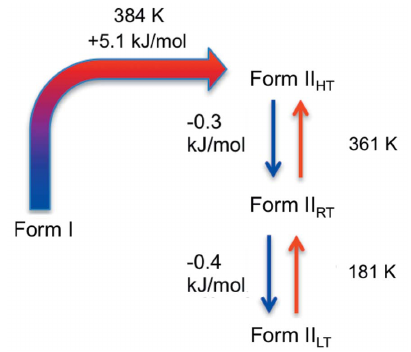
Figure 3 Conversions between polymorphs and phases of 2PrBzIm together with their transition temperatures and enthalpies, as observed in